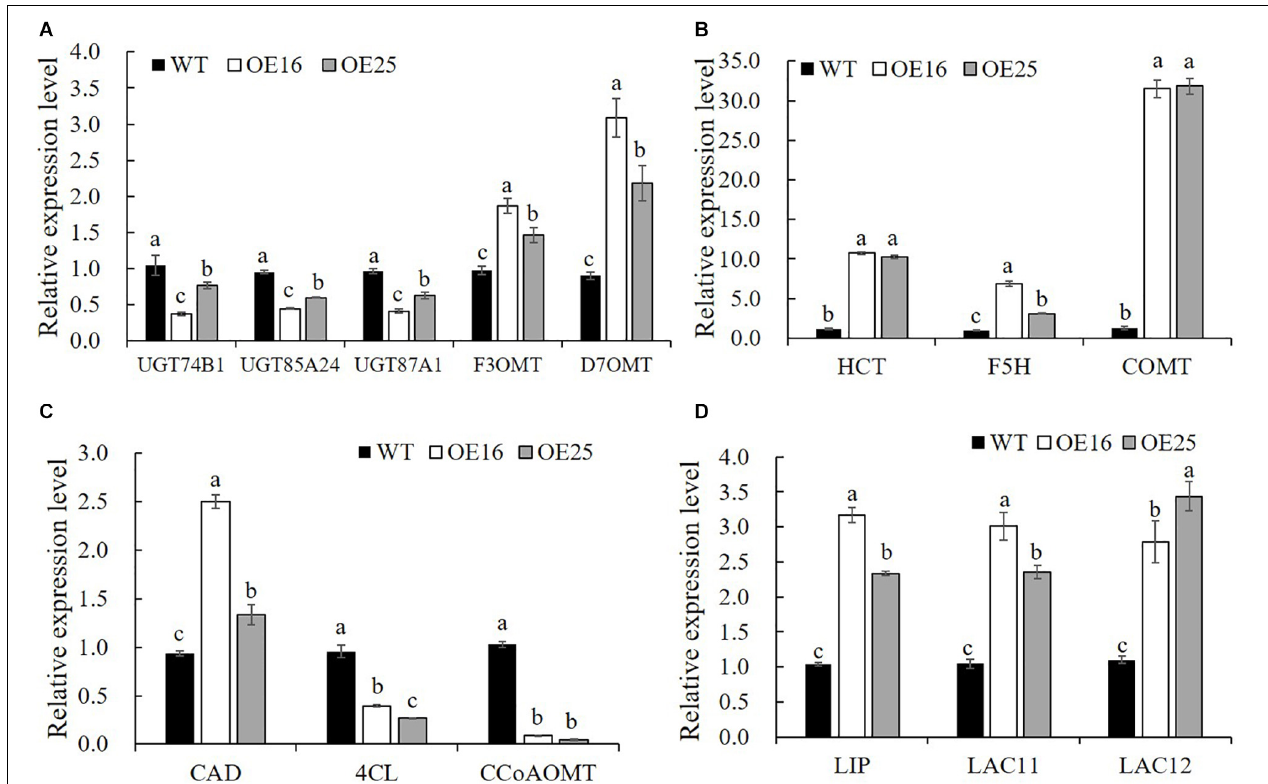
FIGURE 7 | Relative expression levels of genes related to flavonoids biosynthesis (A) and lignin biosynthesis (B–D) in WT plants and OE-MsASMT1 transgenic plants. Data are presented as mean ± SE ( n = 3). The letters indicate the differences between WT and OE-MsASMT1 transgenic plants according to ANOVA analysis ( p <